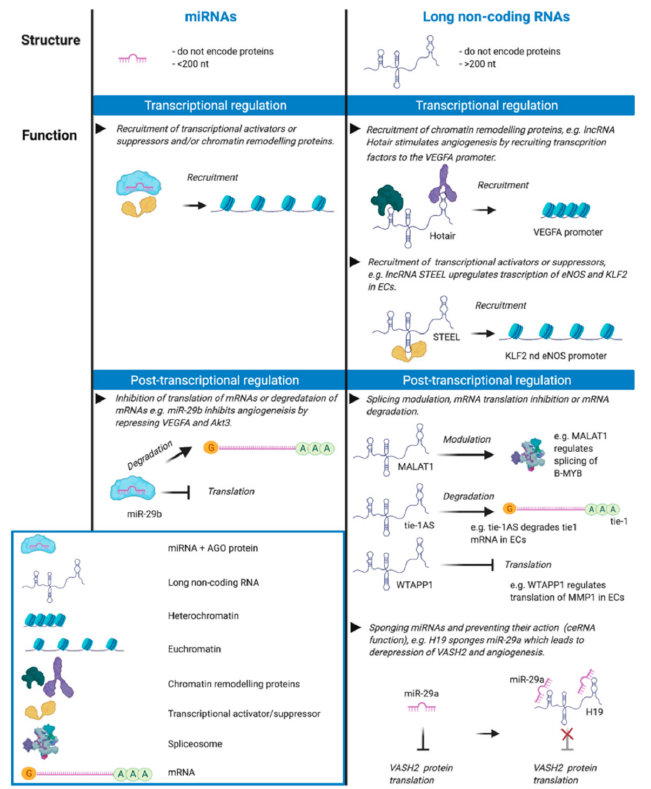
Figure 1. Non-coding RNA is classified as either long or small based on a 200-nucleotide cut-off. Small RNA (e.g., miRNA) has less defined secondary structure whereas long non-coding RNA (lncRNA) has more defined secondary structure required for its function in transcriptional regula- tion by binding chromatin remodelling proteins and recruitment of transcription factors, activators and suppressors. For example, lncRNA STEEL, an endothelial cell-specific lncRNA, upregulates transcription of the genes for endothelial nitric oxide synthase (eNOS) and the transcription factor Kruppel-like factor 2 (KLF2) by recruiting PARP1 to their promoter regions [9]. lncRNA Hotair stimulates angiogenesis by recruiting chromatin remodelling proteins which activate transcription of the gene for vascular endothelial growth factor A (VEGFA) [10]. Nuclear miRNAs play a role in transcription by recruiting transcriptional activator and repressor chromatin remodelling pro- teins [6], and miRNAs are involved in the post-transcriptional regulation of mRNAs by modulating their translation or degradation, e.g., miR-29-b inhibits angiogenesis by negatively regulating the expression of VEGFA and Akt3 [11,12]. lncRNAs can act post-transcriptionally to regulate mRNA by modulating mRNA splicing, translation and mRNA degradation, e.g., lncRNA MALAT1 plays a role in angiogenesis through several mechanisms including the regulation of alternative splicing of the oncogenic transcription factor B-MYB in endothelial cells [13], WTAPP1 lncRNA promotes migra- tion by increasing the expression of the matrix metalloproteinase MMP1 [14] and Tie-1AS lncRNA selectively binds and degrades tie-1 mRNA leading to specific defects in cell junctions and tube formation [15]. Further, lncRNAs can act as sponges to bind and sequester miRNAs, e.g., lncRNA H19 sponges miR-29a resulting in derepression of Vasohibin 2 (VASH2) and angiogenesis [16]. This figure was created with